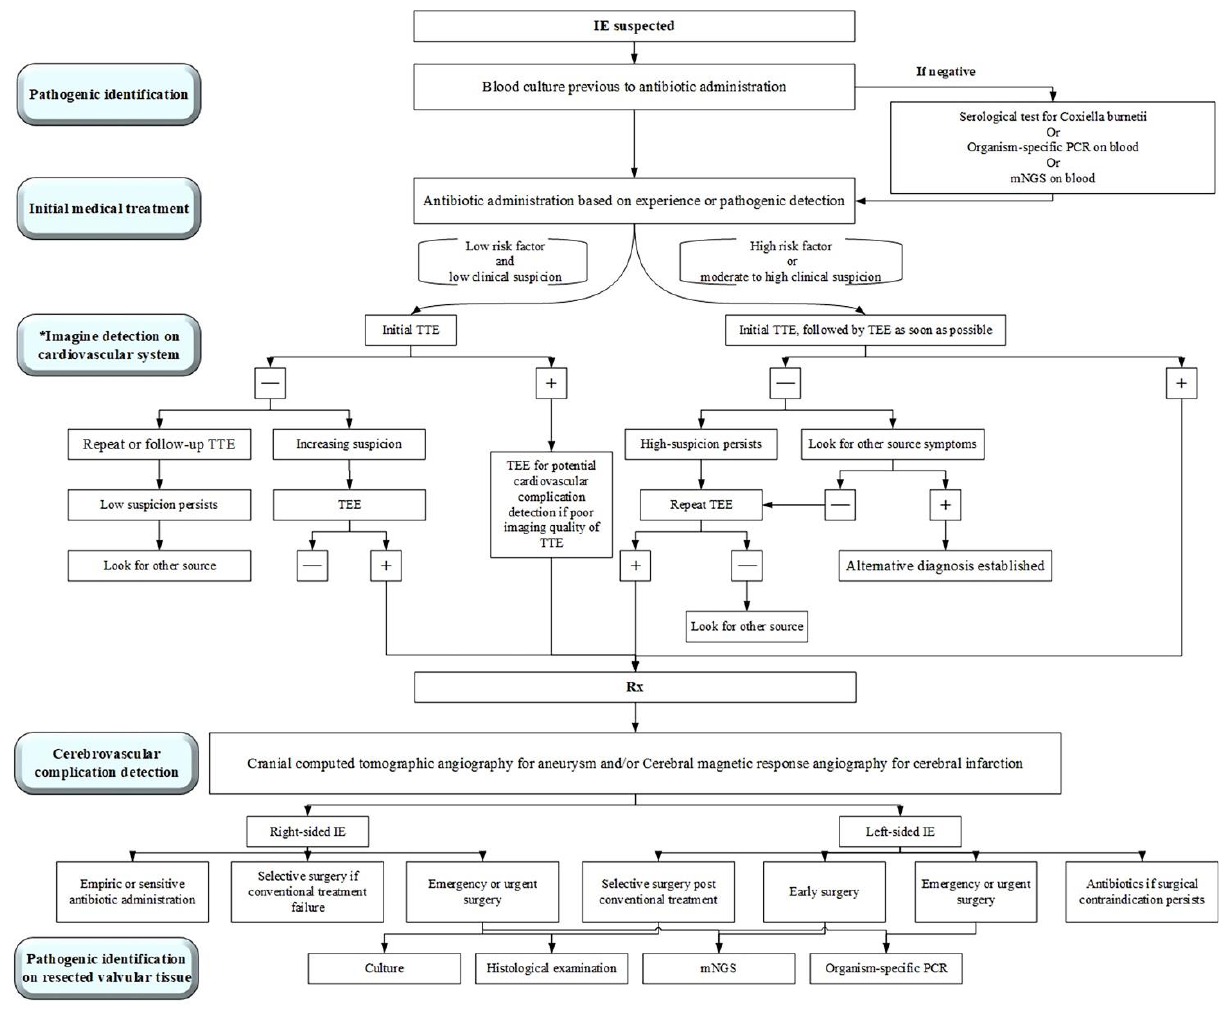
Figure 3. A simplified approach to the diagnosis and management of an infective endocarditis (IE) patient. Rx indicates prescription; TEE, transesophageal echocardiography; TTE, transthoracic echocardiography; mNGS, metagenomic next-generation sequencing; PCR, polymerase chain reaction; * Modified from Baddour et al. [10].